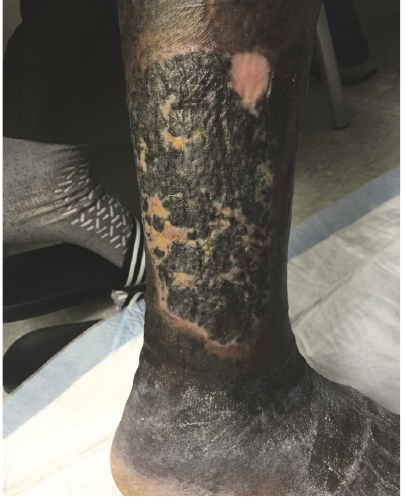
Figure 7: Wound healed within 3